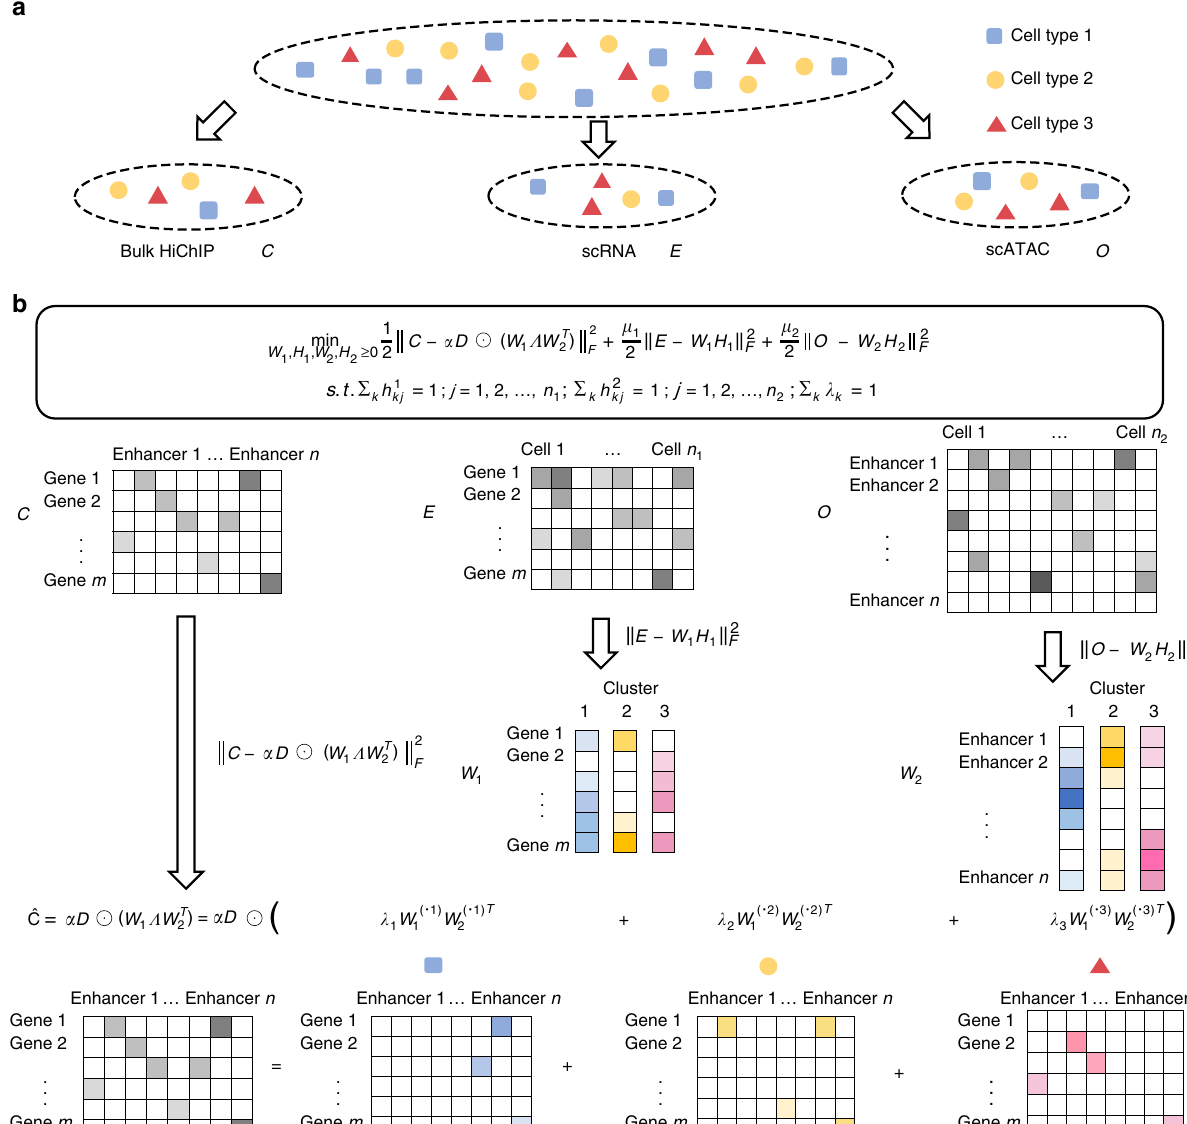
Fig. 1 Overview of the DC3 method. a DC3 performs joint analysis using three types of data from separate samples from the same cell population: scRNA- seq, scATAC-seq, bulk HiChIP. E denotes the genes expression level in each cell measured in scRNA-seq; O denotes enhancer chromatin accessibilities in each cell measured in scATAC-seq; C denotes the enhancer-promoter interactions strength (loop counts) between each gene and each enhancer measured in bulk HiChIP. b A graphical example for simultaneously decomposing E , O , C to get the underlying clusters and cluster-speci fi c HiChIP in K = 3 case: (1) E (cid:1) W 1 H 1